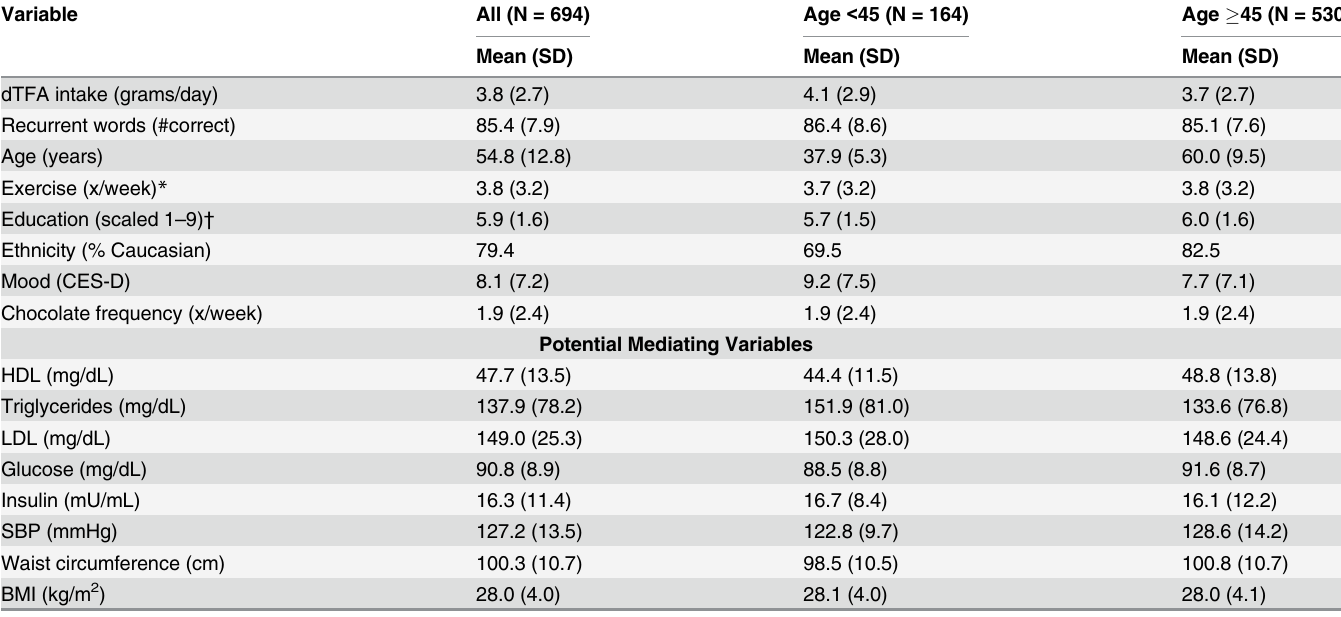
Table 1. Sample Characteristics (Men).